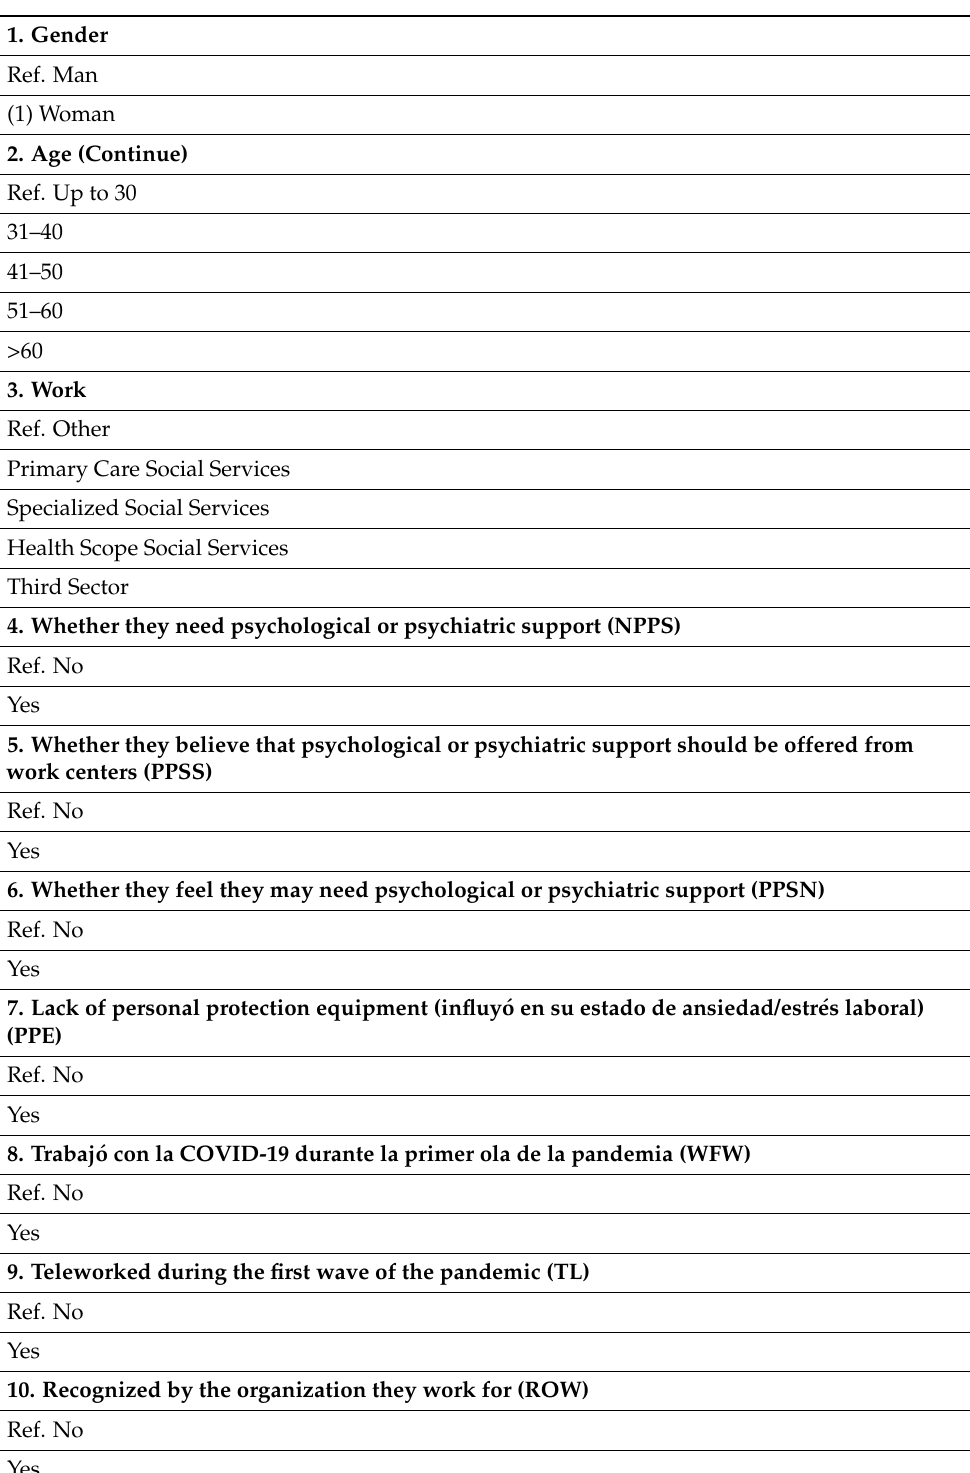
Table 1. Variables used in binary logistic